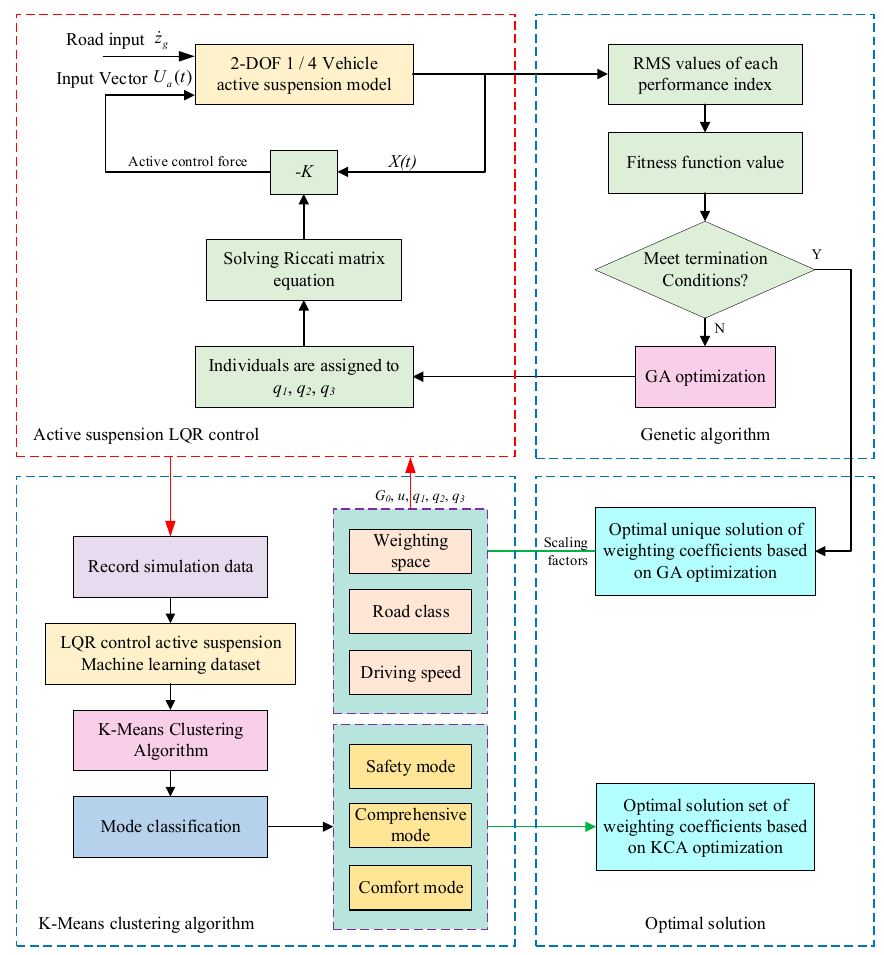
Figure 1. Principle of GKL algorithm .